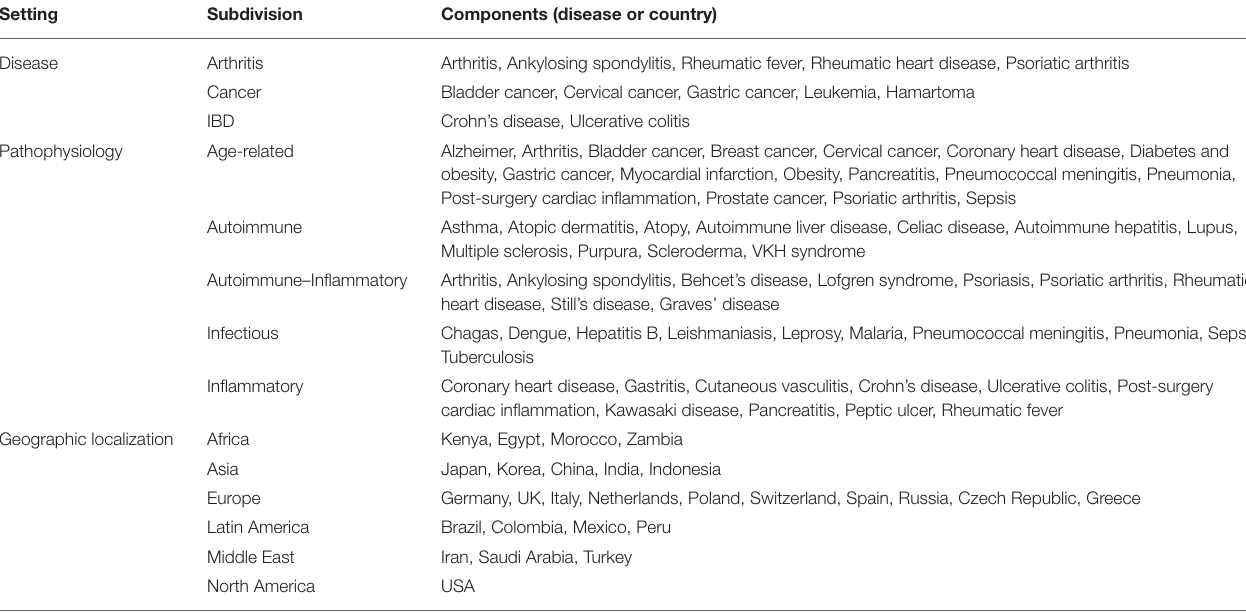
TABLE 1 | Composition of the subdivision settings.